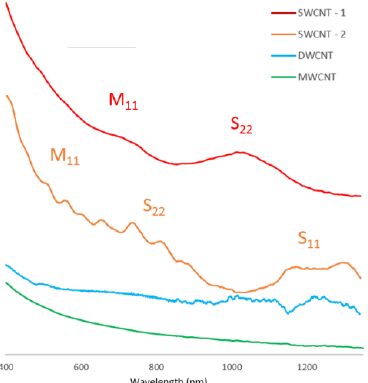
Figure 2. Ultra-violet/visible (UV/Vis) absorption spectra for all as prepared CNT suspensions. The absorption values have been offset to allow easier viewing. Included in the figure are reference labels for semiconducting tube Van Hove singularity transitions S 11 and S 22 and metallic tube Van Hove singularity transition M 11